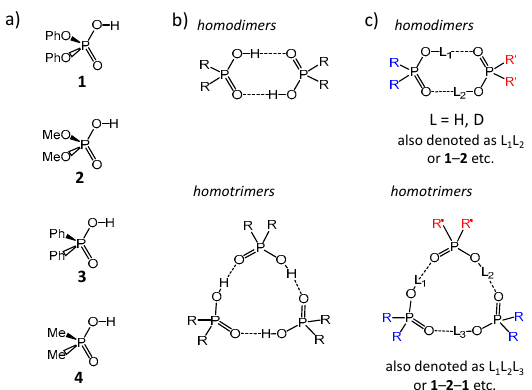
Figure 1. Schematic structures of molecules and their complexes, studied in this work. ( a ) diphenylphosphoric 1 , dimethylphosphoric 2 , diphenylphosphinic 3 , and dimethylphosphinic 4 acids. ( b ) Self-associates of phosphinic and phosphoric acids. ( c ) Heteroassociates of phosphinic and phosphoric acids.